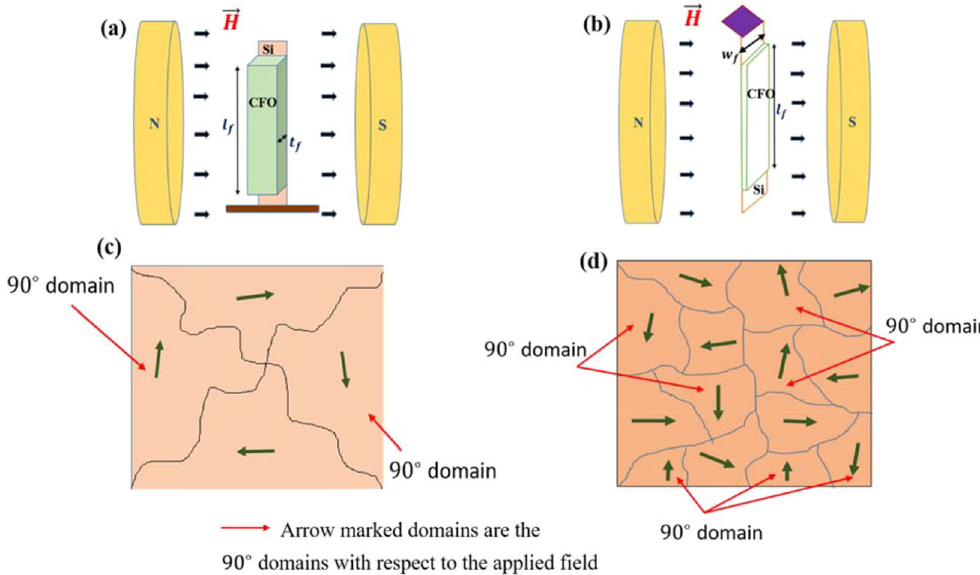
Figure 4. ( a ) The schematic view of CFO/Si composite when the field is applied along the width. ( b ) The schematic representation for the field is applied along the thickness. ( c ) The exposed film surface in in-plane geometry consisting of less number of 90° domains. ( d ) The exposed surface area in out-of-plane geometry having a large no. of 90°